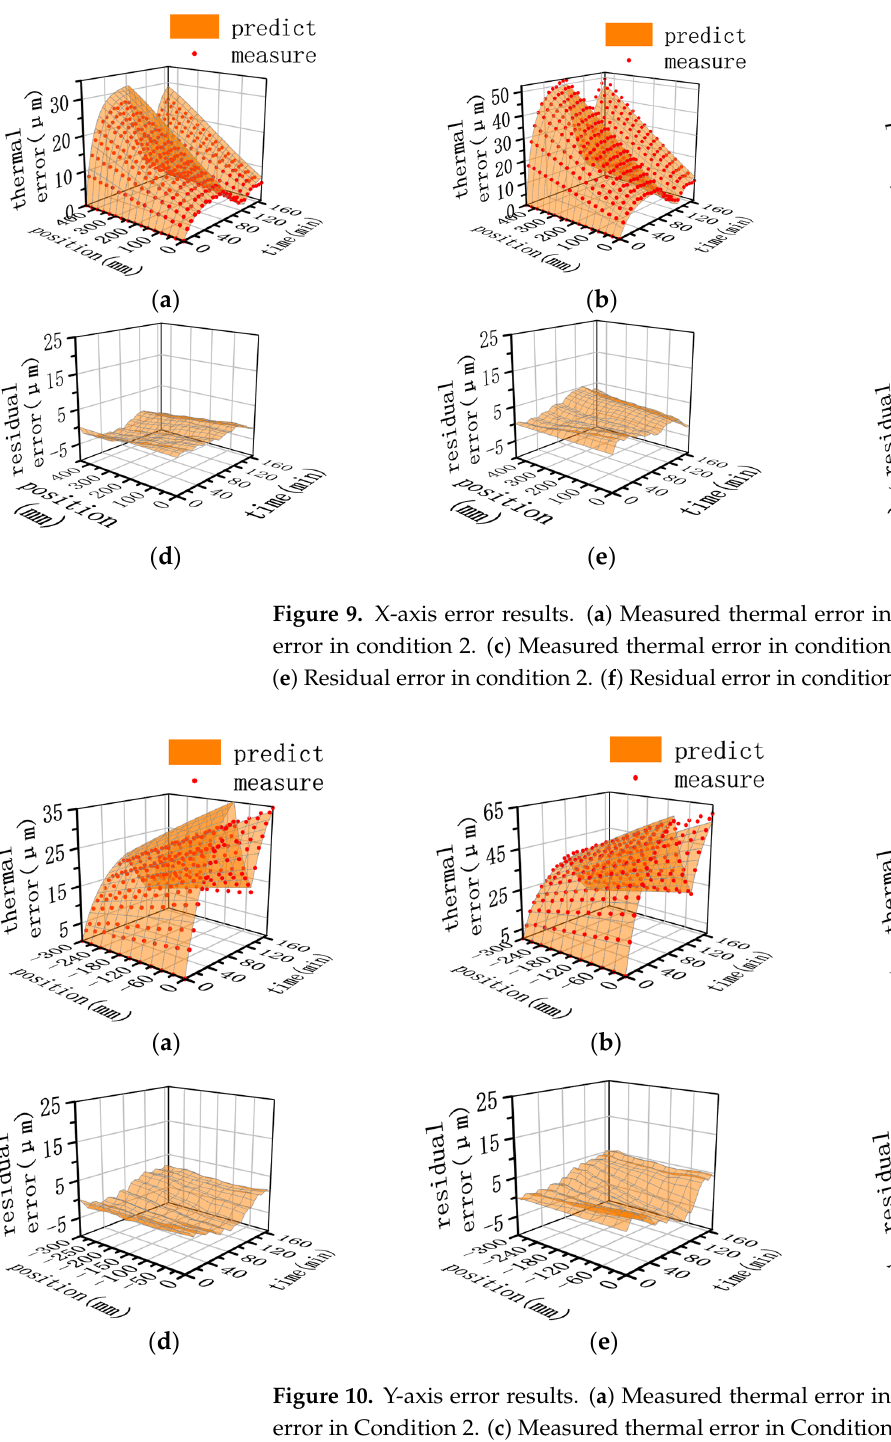
( f ) Figure 11. Z-axis error results. ( a ) Measured thermal error in Condition 1. ( b ) Measured thermal error in Condition 2. ( c ) Measured thermal error in Condition 3. ( d ) Residual error in Condition 1. ( e ) Residual error in Condition 2. ( f ) Residual error in Condition 3. The residual error of the thermal error prediction model is within 15% of the meas- ured thermal error P – V value. Thus, the parameter identification algorithm has sufficient fitting accuracy for the purposes of this experiment, and the parameter simplification method proposed in this paper is validated. 5.2. Verification of Compensation Method An experiment was conducted to verify the effectiveness of the proposed thermal error compensation method, following a similar process to that in the parameter identifi- cation experiment. The simulation loading conditions used for the verification experiment are shown in Figure 12. In order to verify the repeatability of the compensation effect, three sets of independent thermal error compensation effect verification experiments were carried. The final experimental results are shown in Figure 13.